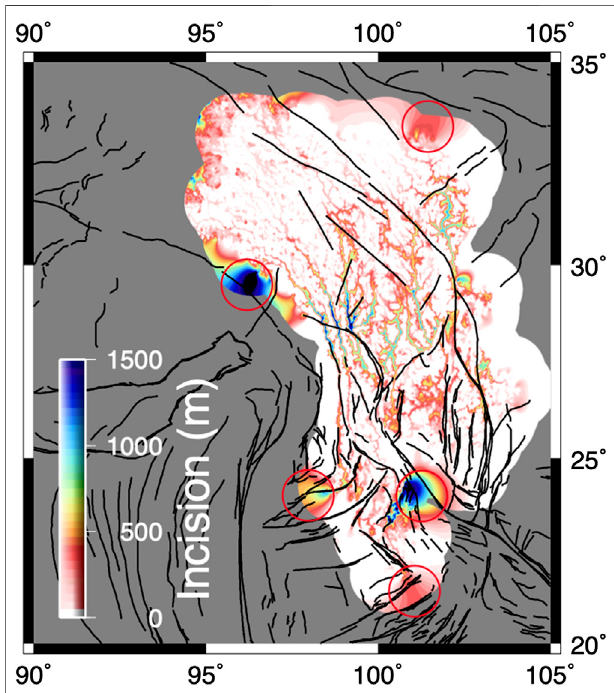
FIGURE 8 | Predicted incision. The amount of predicted incision across SE Tibet assuming that the low-relief topographical surface represents a pre- incision landscape. Incision is focused along the rivers in the Three Rivers region, as would be expected from a simple topographic interpolation. Severalplottingartifactsarehighlightedwithredcirclesandthesere fl ectareas that are unconstrained by the dataset.